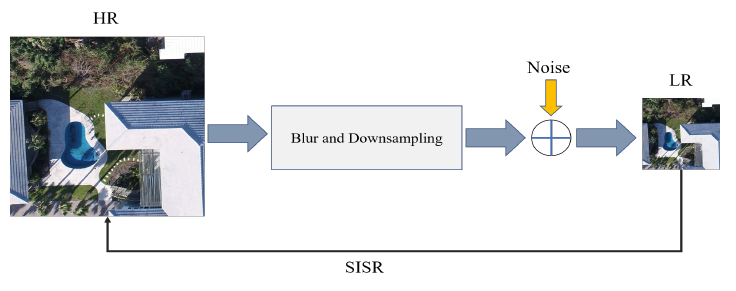
Figure 1. The overall framework for